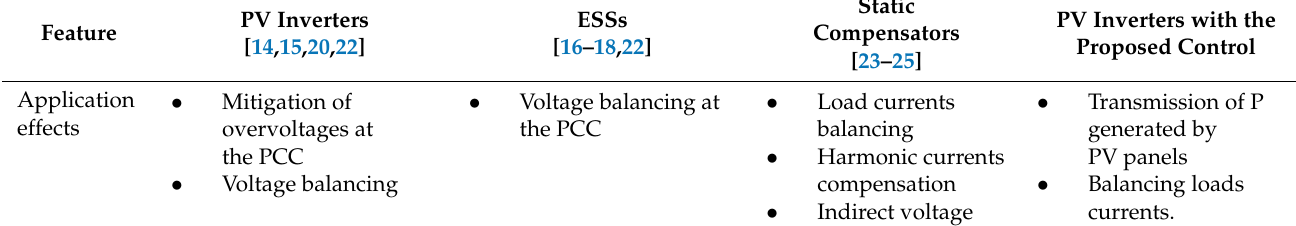
Table 2. Comparison of solutions used to improve operating parameters of LV